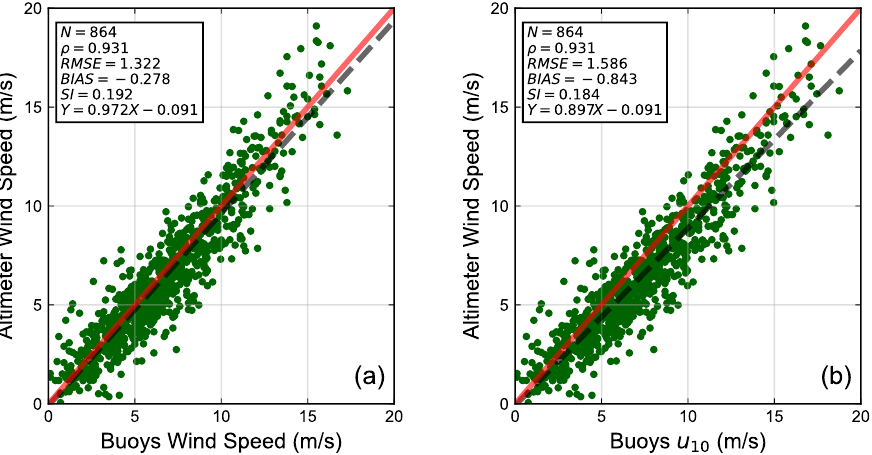
Figure A1. WS validation of the collocated multi-mission altimeter dataset against the collective buoy observations in the Northeast without ( a ) and after ( b ) being adjusted to 10 m height. N is the collocated dataset sample size and ρ is Pearson’s correlation coefficient. The dashed grey line represents the theoretical Y = X line assuming the two types of measurements are identical. The red line represents the OLS linear regression fit using X and Y which represent the collocated buoy and altimeter